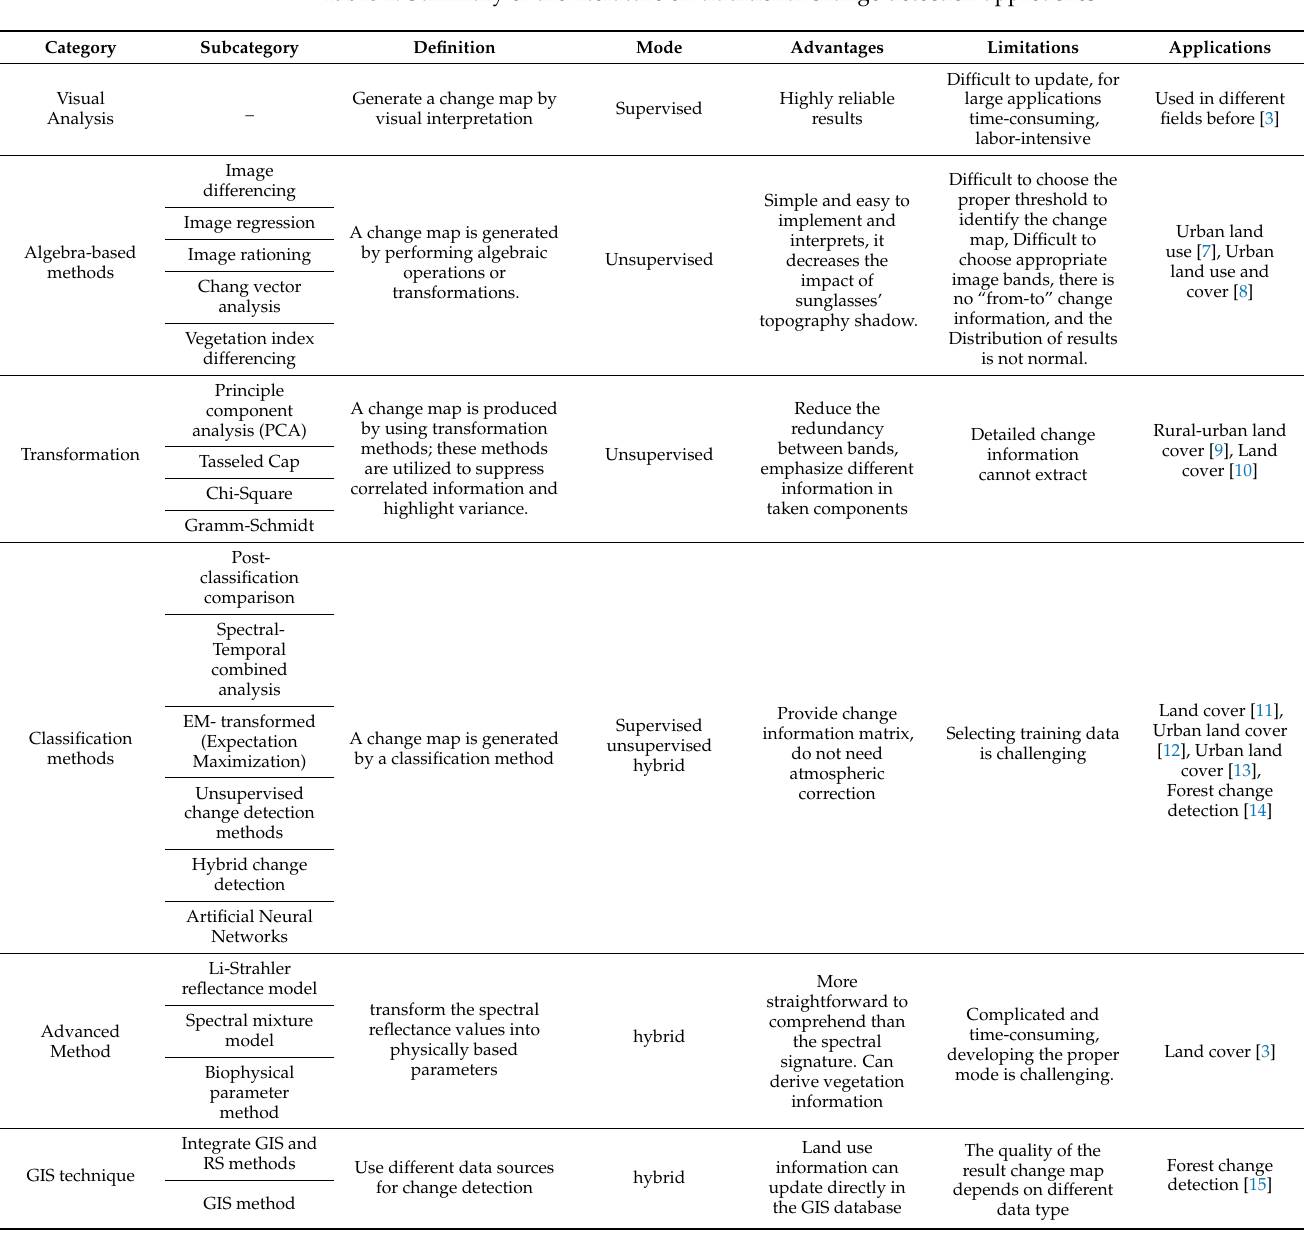
Table 1. Summary of the literature on traditional change detection